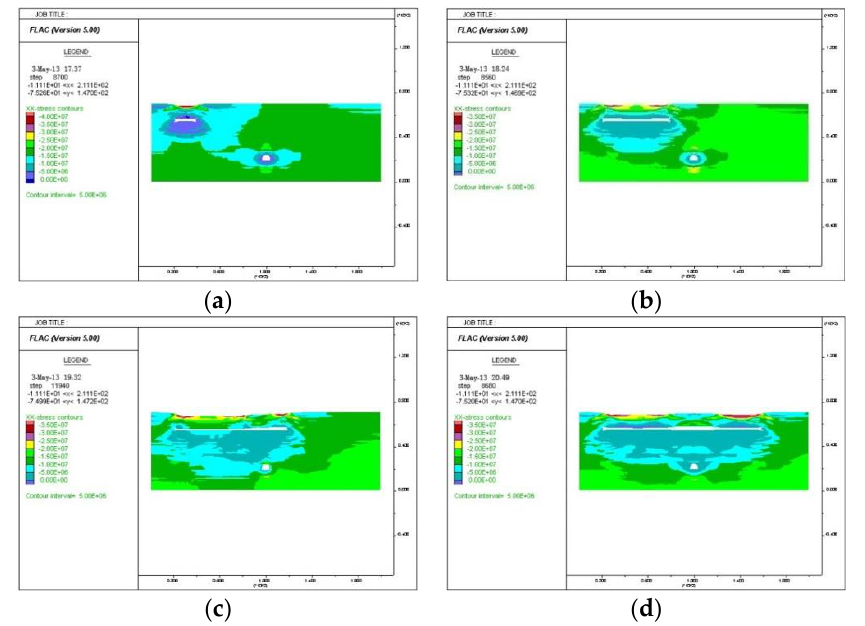
Figure 11. Horizontal stress distribution of roadway surrounding rock during bolt support. ( a ) Working face is 60 m away from the roadway. ( b ) Working face is 20 m away from the roadway. ( c ) Working face spans the roadway 20 m. ( d ) Working face spans the roadway 60 m.